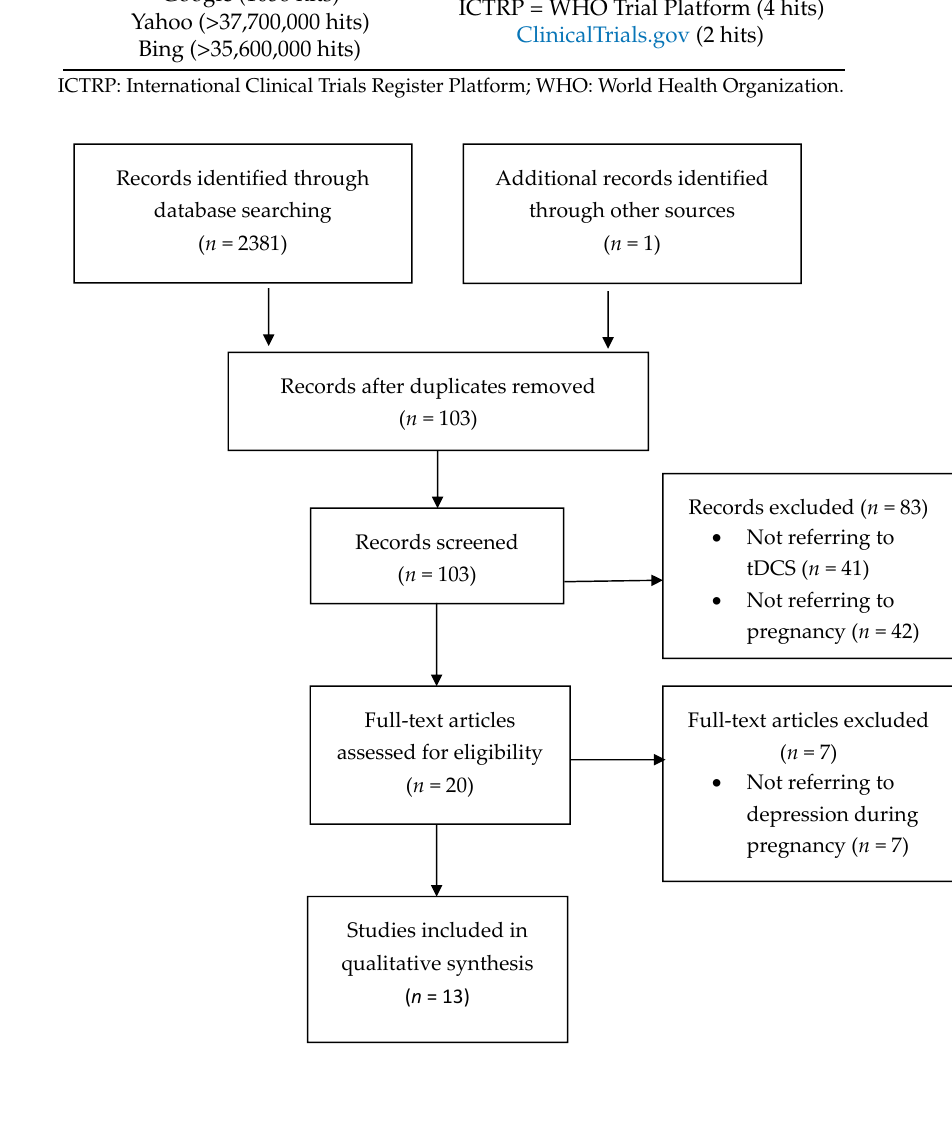
Figure 1. PRISMA flow diagram. tDCS—transcranial direct current stimulation.